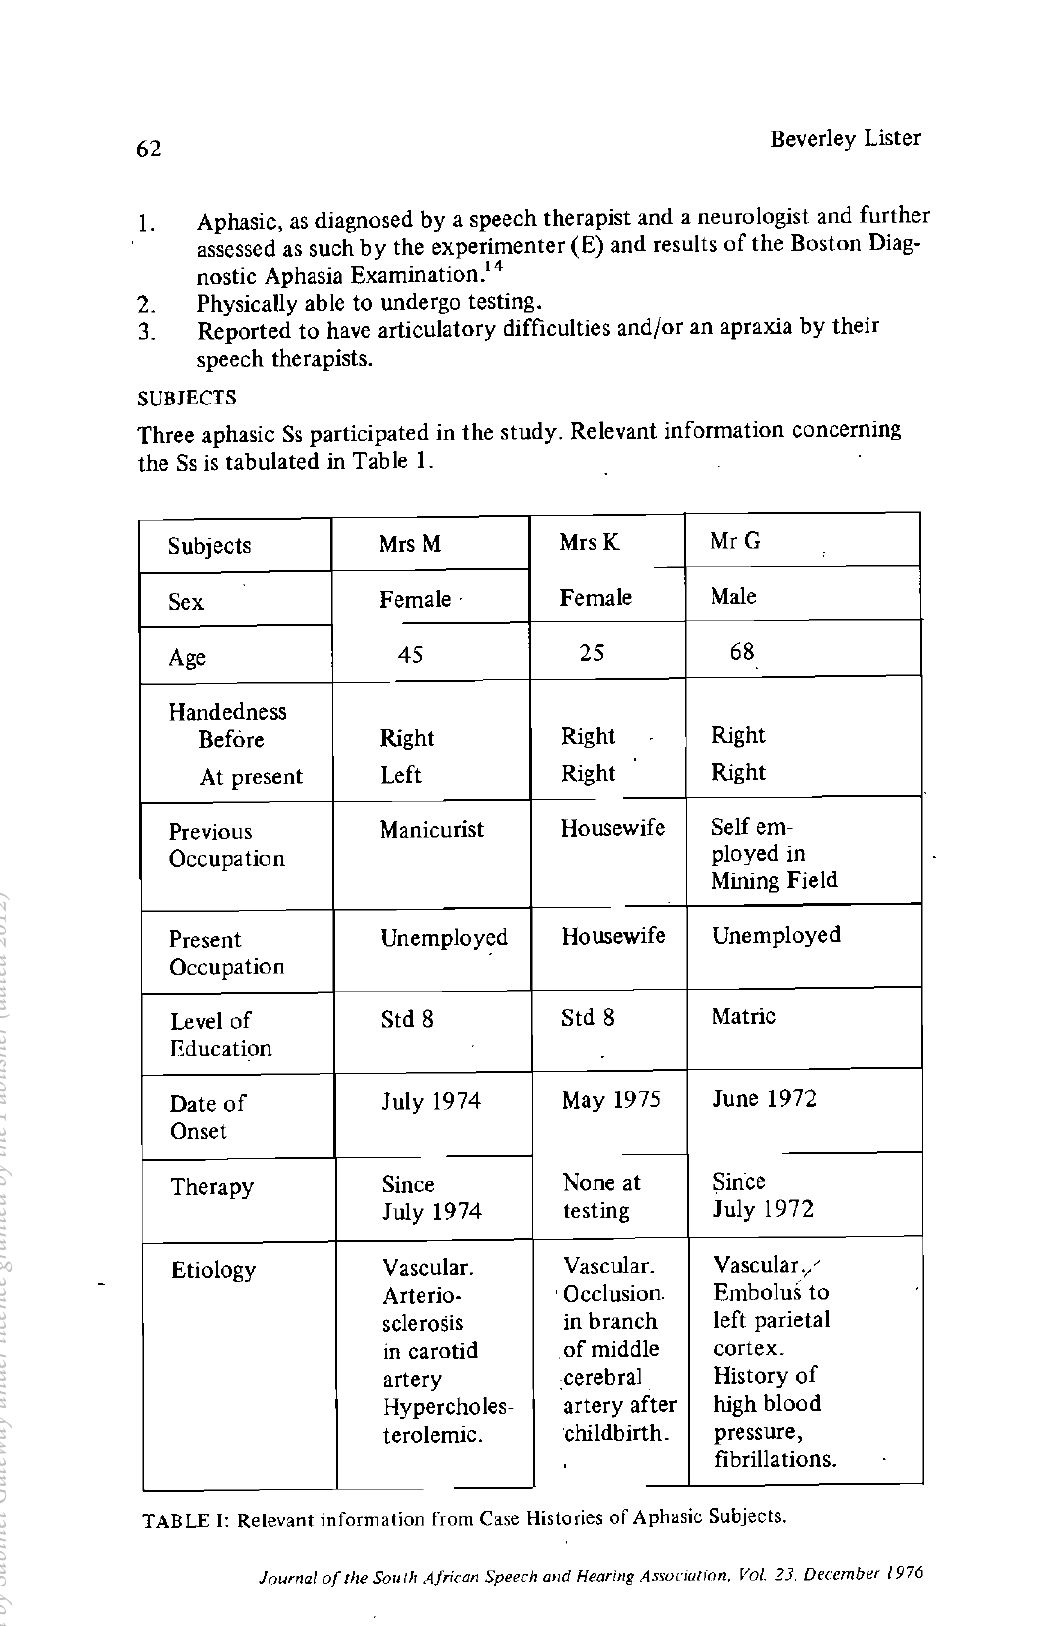
TABLE I: Relevant information from Case Histories of Aphasic Subjects. Journal of the South African Speech and Hearing Association, Vol. 23, December